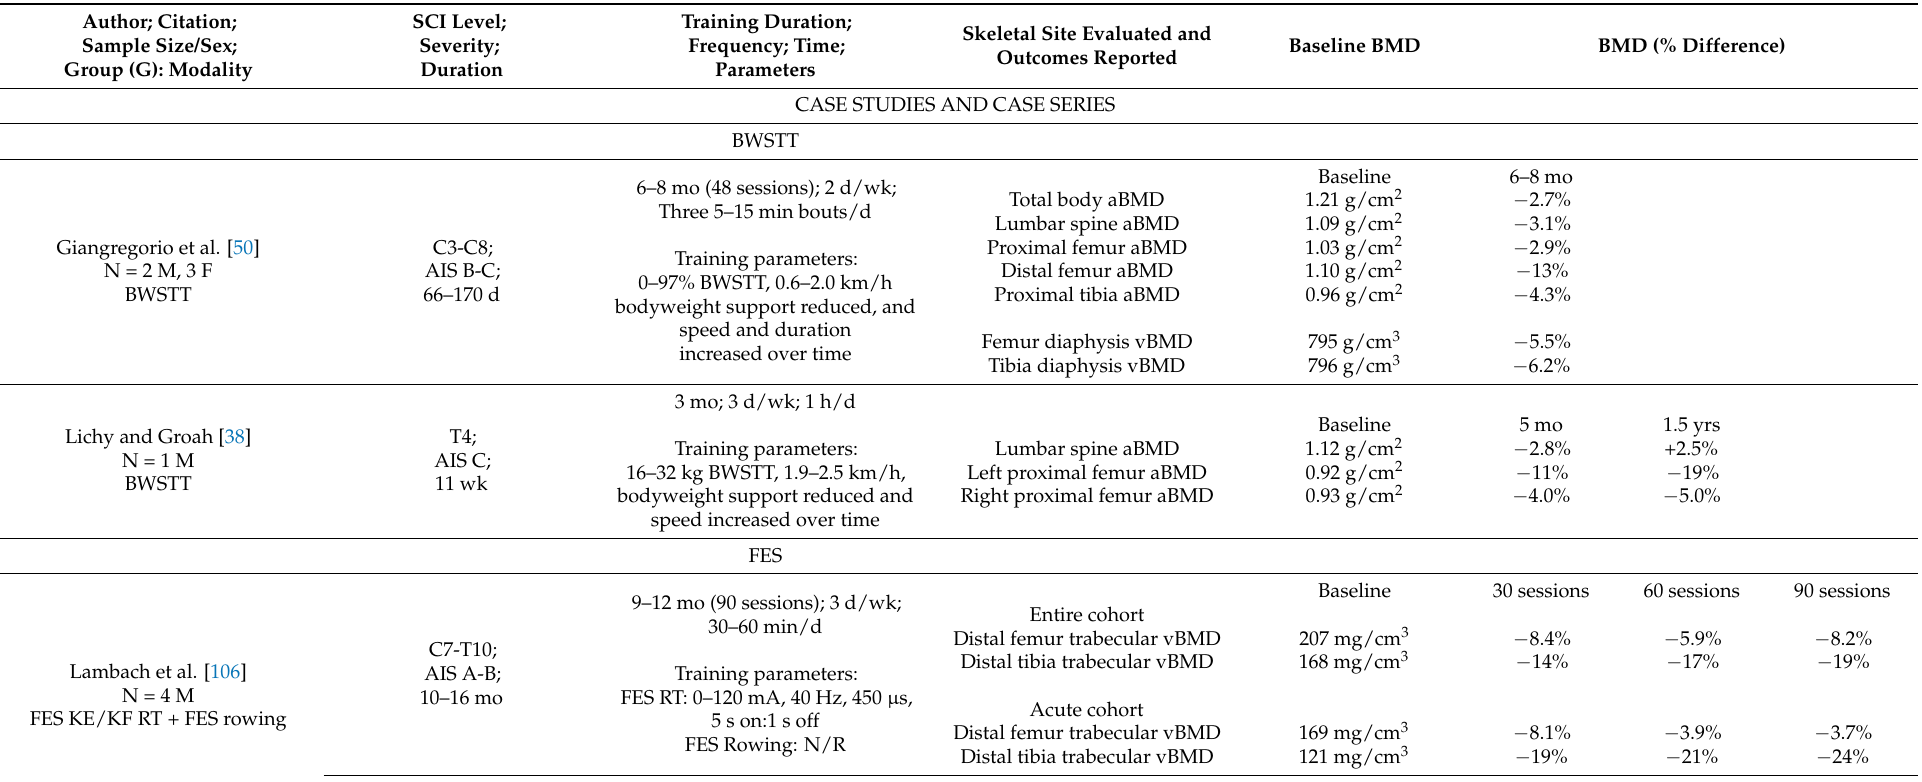
Table 1. Case studies, case series, and cross-sectional studies evaluating the effects of activity-based physical therapy (ABPT) and/or loading on bone mineral density (BMD) in adults with acute or subacute spinal cord injury